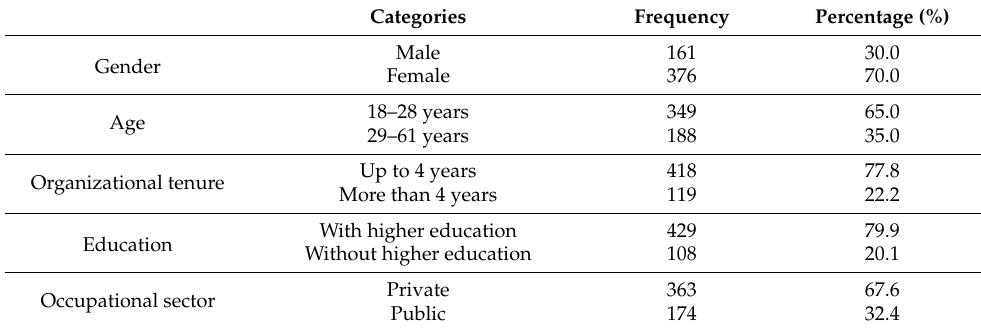
Table 1. Characteristics of the